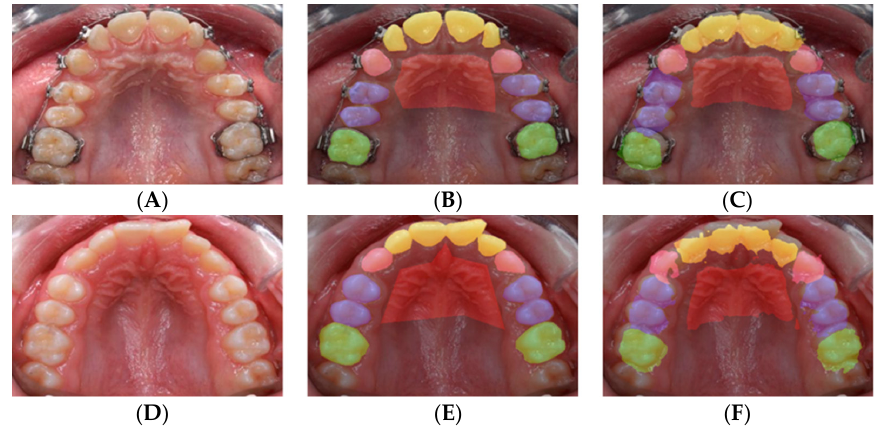
Figure 6. Family of teeth/rugae average sample result for DenseNet, ( A – C ); Family of teeth average sample result for SegNet ( D – F ); original images ( A , D ); image labels ( B , E ); image predictions ( C , F ).